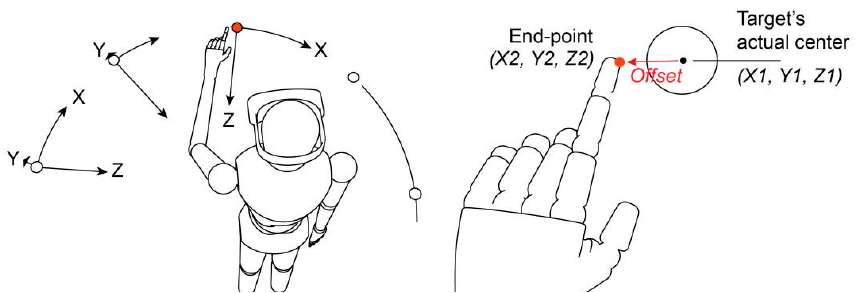
Figure 7. An illustration about the end-point’s offset or scatter from the target’s actual position.